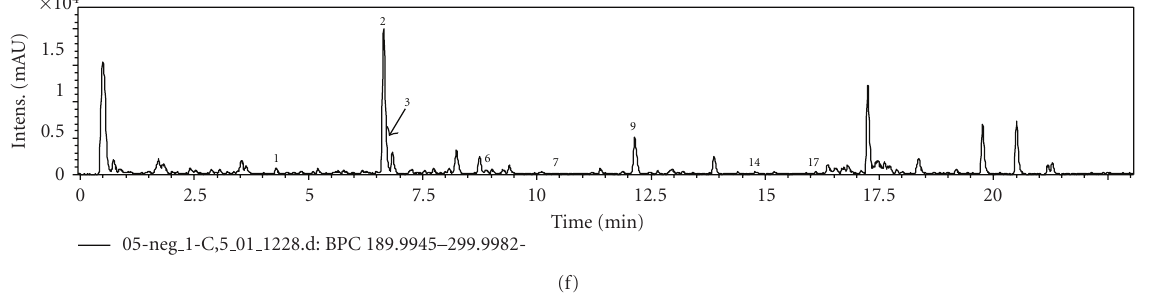
Figure 3: UPLC-UV chromatogram and BPC of the samples. (a): UV of MGHQ-TE, (b): BPC of MGHQ-TE, (c): UV of MJHQ-TE, (d): BPC of MJGHQ-TE, (e): UV of HQ-TE, (f): BPC of HQ-TE.